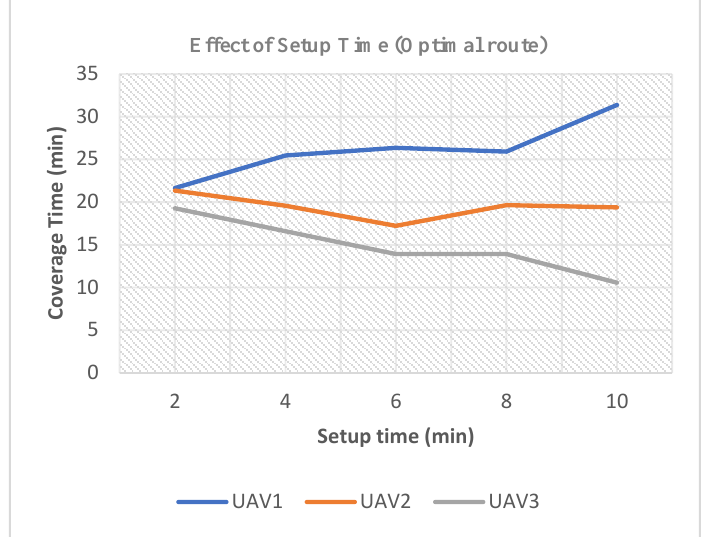
Figure 11. The Effect of Setup Time on Coverage (optimal route).